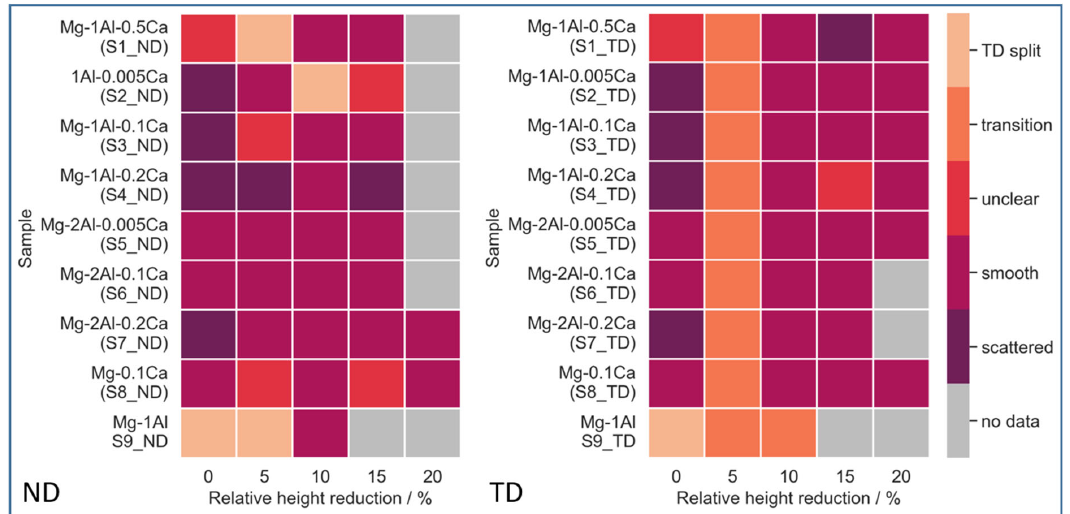
Figure 2. Observed types of pole fi gure for samples with di ff erent compositions and rolling reduc- tions (in %) deformed in normal direction (ND) and transverse direction (TD). Yellow and green background colours indicate whether the type was observed for ND (green), TD (yellow), or both